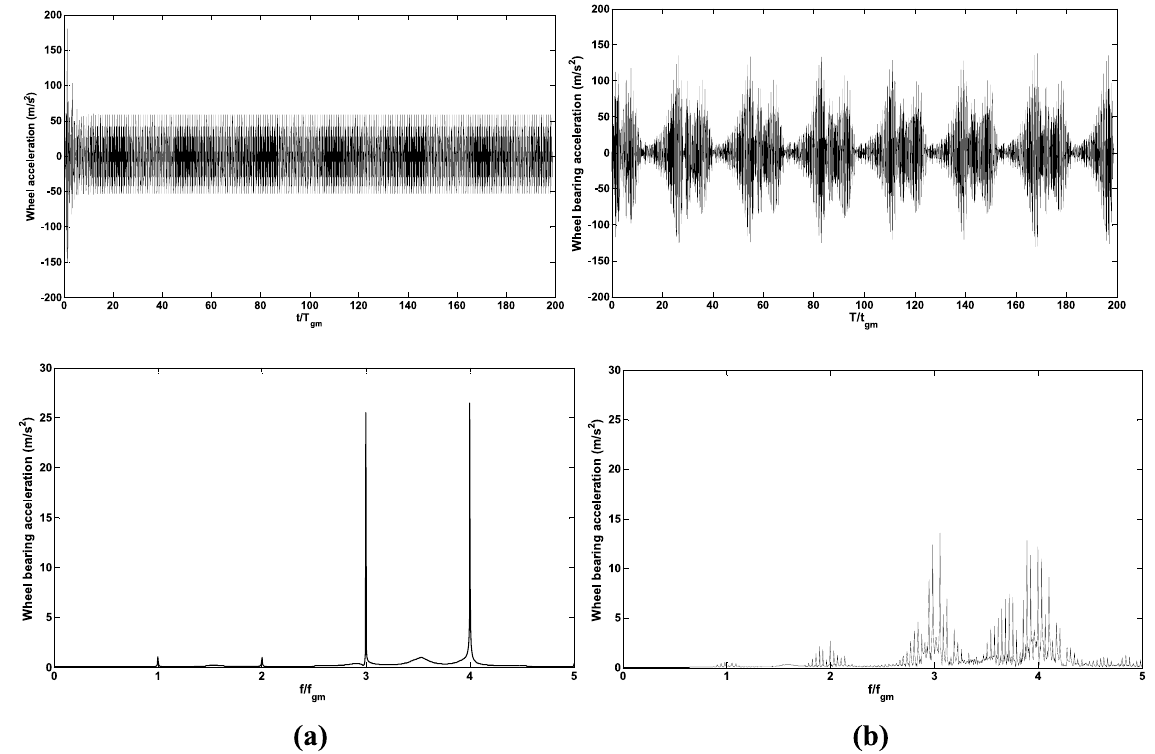
Fig. 10. Time evolution and spectra of the acceleration of the wheel bearing for constant load case (a) and time varying load case